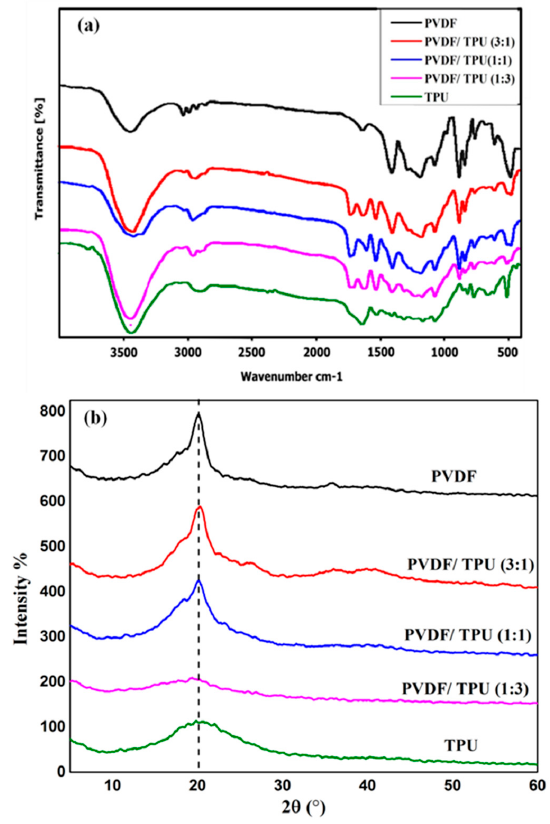
Figure 4. ( a ) FT-IR and ( b ) XRD Analysis of PVDF/TPU Composite Nanofiber.